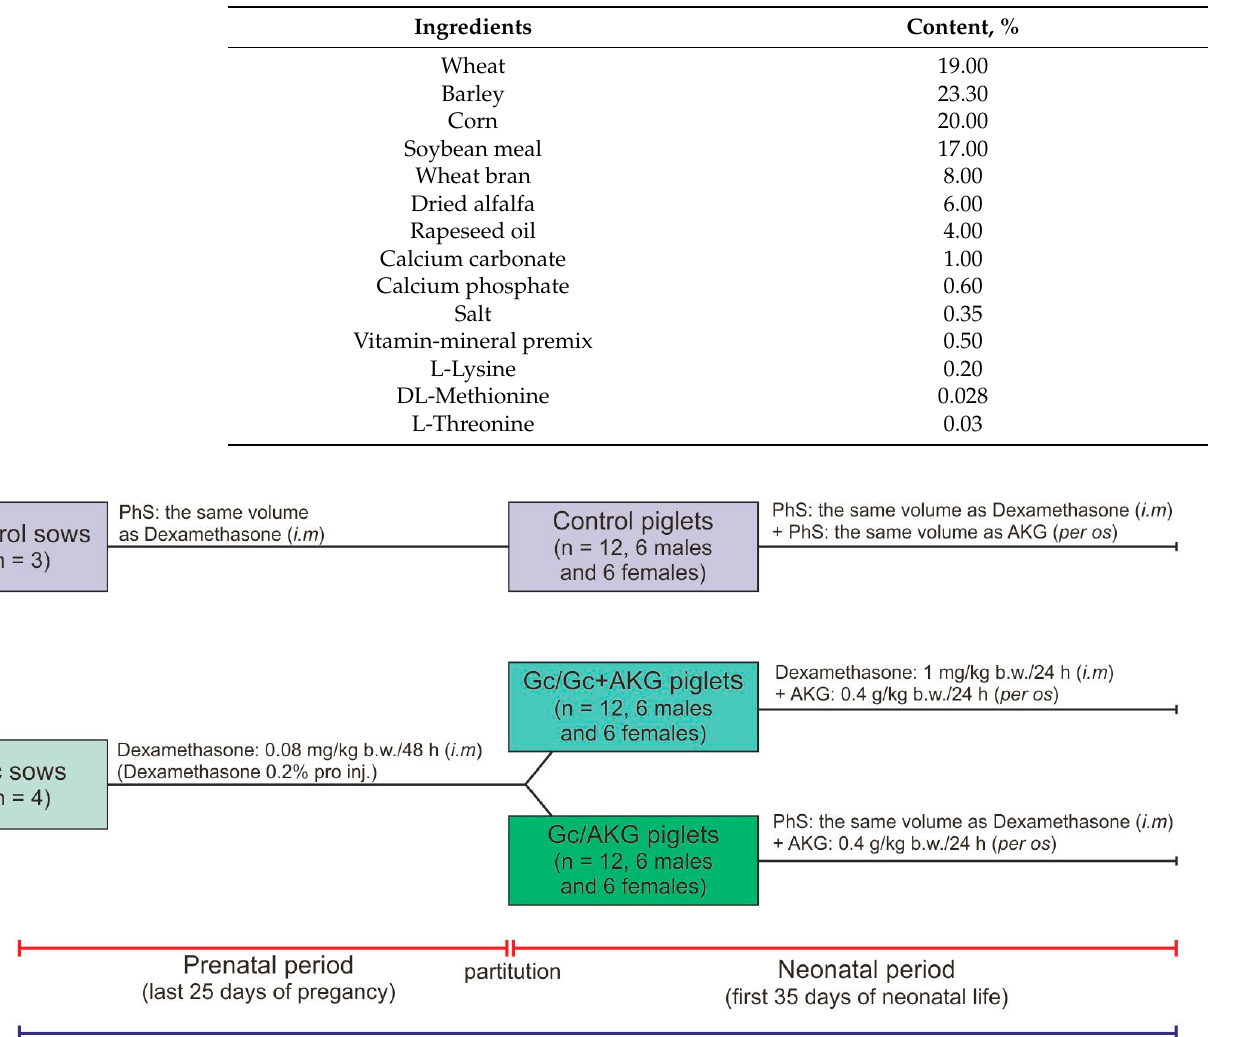
Table 1. Composition of feed mixture used for sows during pregnancy and lactation.